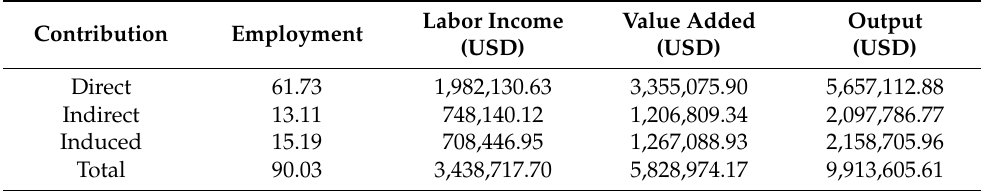
Table A3. Contribution of GTM Visitor Spending to Duval, Flagler, and St. Johns Counties (Annual). Contribution